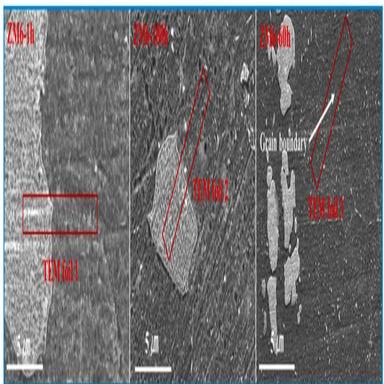
SEM images showing the positions of three site-specific TEM foils.